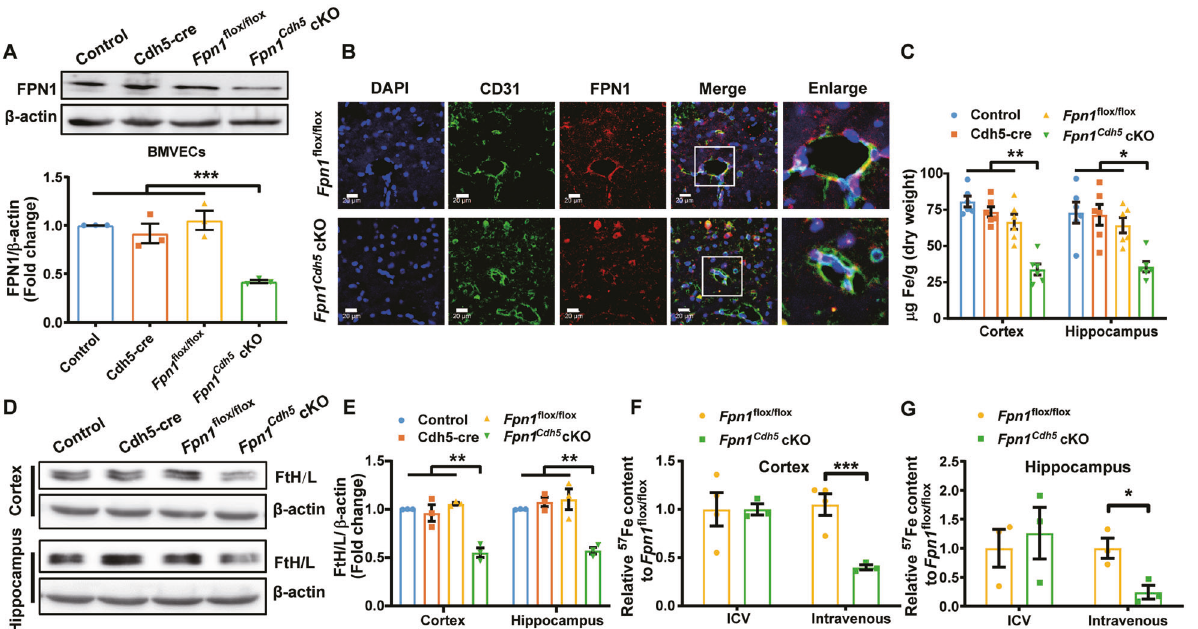
Fig. 3 FPN1 of BMVECs is a key molecule for brain iron uptake. A is western blot analysis of FPN1 protein levels in BMVECs of 9-week-old Fpn1 Cdh5 cKO and different control mice. The relative expression levels were normalized to β -actin levels and presented as the mean ± SEM, n = 3, *** p < 0.001. B is immuno fl uorescent staining of CD31 and FPN1 in hippocampus of Fpn1 Cdh5 cKO and control mice. Higher magni fi cation images are shown in the last column. Scale bar = 20 μ m. C is total brain iron determined by ICP-MS in 9-week-old Fpn1 Cdh5 cKO and control mice. The values are presented as the mean ± SEM, n = 6, * p < 0.05 and ** p < 0.01. D is ferritin protein level in the cortex and hippocampus of Fpn1 Cdh5 cKO and control mice. E is the relative expression levels normalized to β -actin levels and expressed as the mean ± SEM, n = 3, ** p < 0.01. F , G are the levels of 57 Fe in cortex ( F ) and hippocampus ( G ) of 3-month-old Fpn1 Cdh5 cKO and Fpn1 fl ox/ fl ox control mice determined by ICP-MS following intravenous injection of 57 Fe. Values are presented as the mean ± SEM, n = 4 ( Fpn1 fl ox/ fl ox ) vs. n = 3 ( Fpn1 Cdh5 cKO), * p < 0.05 and *** p <